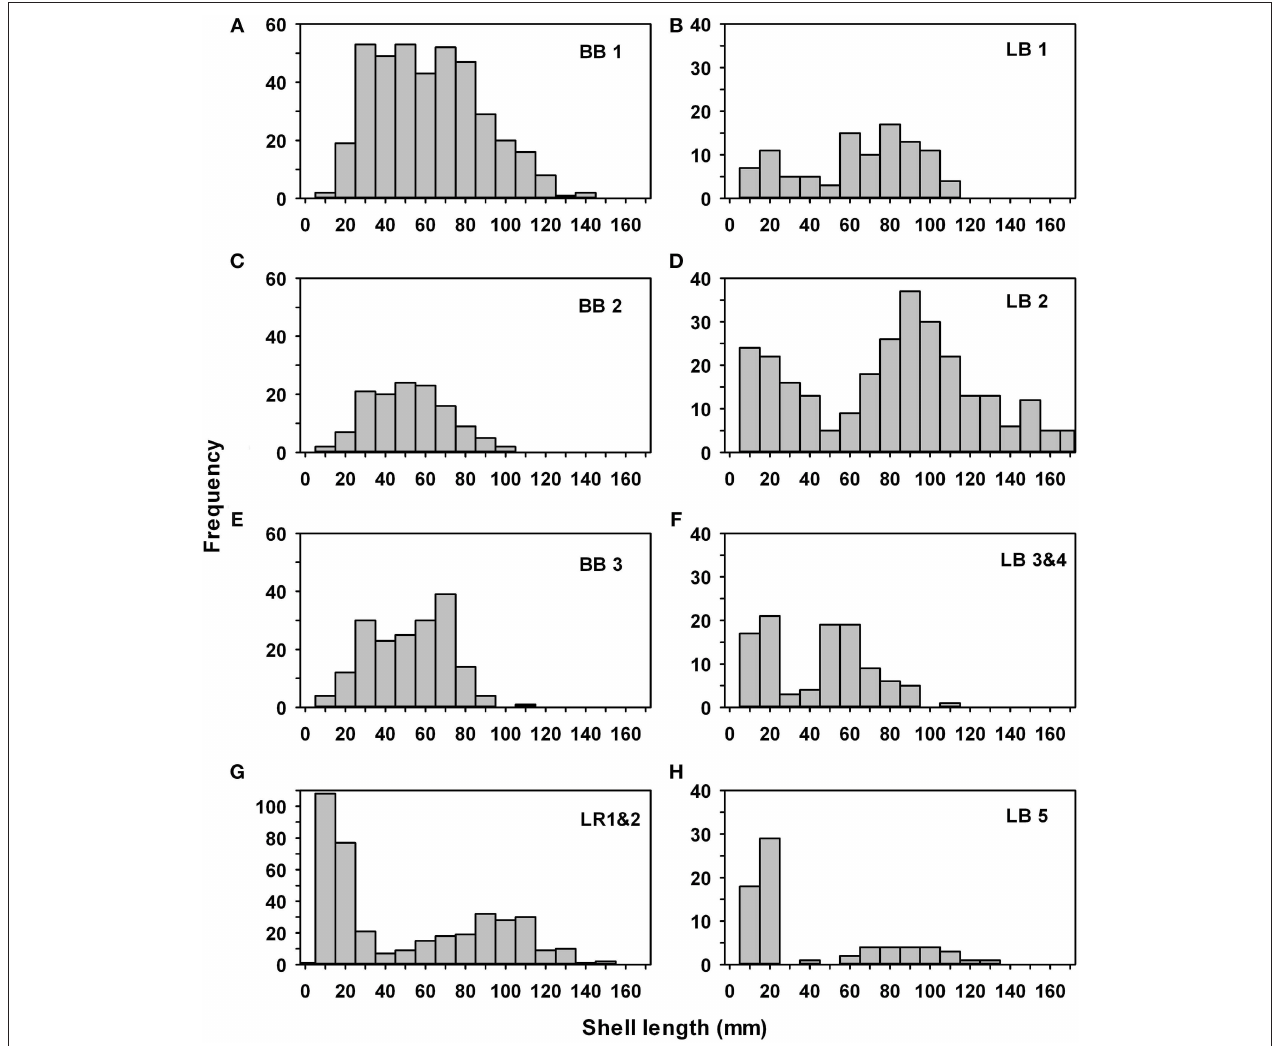
FIGURE 6 | Size-frequency histograms for all oysters collected on constructed oyster reefs in Broad Bay reefs 1 (A), 2 (C), and 3 (E), Linkhorn Bay reefs 1 (B), 2 (D), 3 and 4 (F), and 5 (H), and the Eastern Branch of the Lynnhaven River reefs 1 and 2 (G). BB, Broad Bay, LB, Linkhorn Bay, LR, Lynnhaven